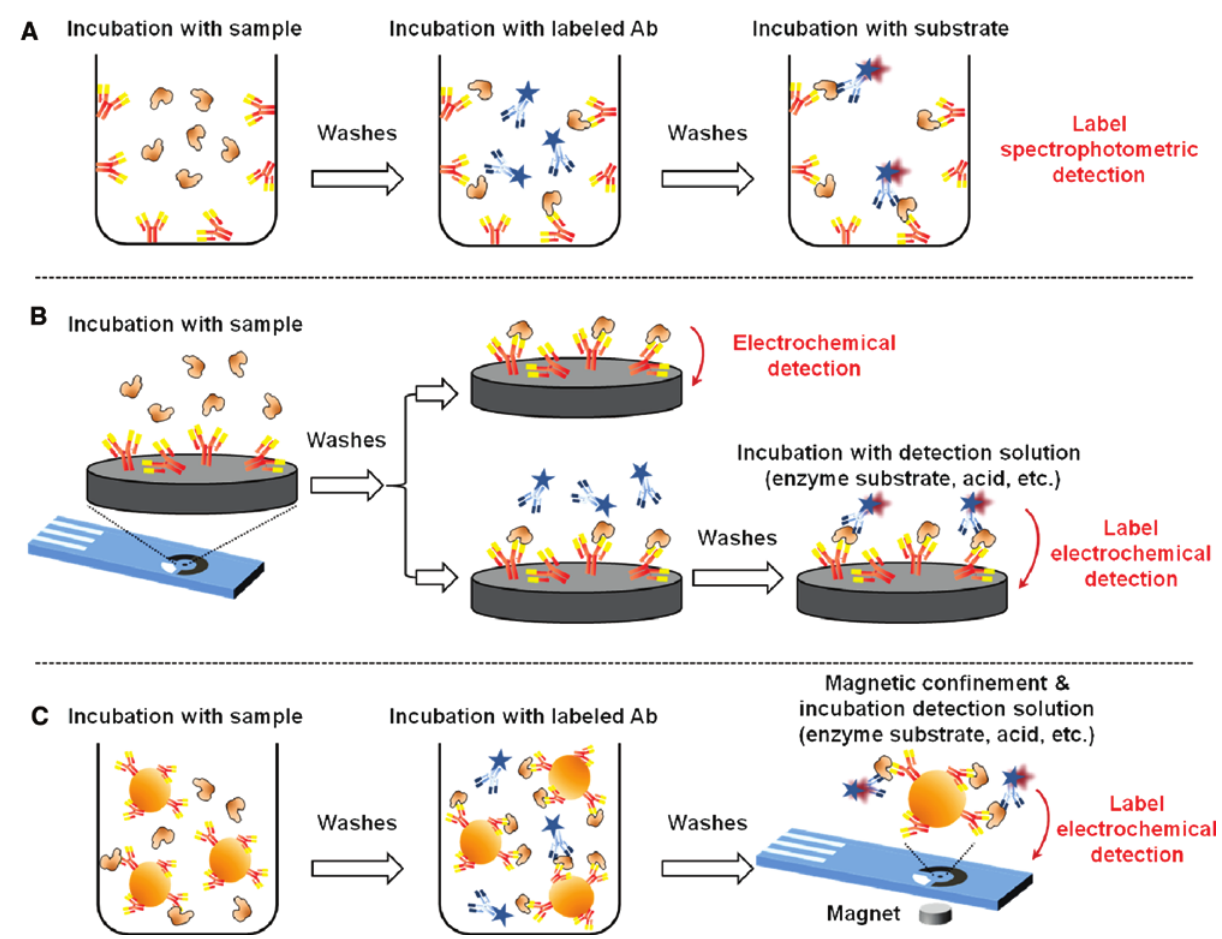
Figure 1: Scheme of different immunoassay and immunosensor formats. (A) Classical multistep ELISA performed at microtitter plate wells. Detection is carried out by incubating with an enzyme-labeled Ab and detecting spectrophotometrically the enzyme activity by adding the appropriate chromophore enzyme substrate. (B) Electrochemical immu- nosensor developed by immunoengineering of the electrode surface coupled to either straightforward detection of the immuno-binding event (top) or incubation of a labeled Ab and detection of the label. (C) Electrochemical magnetoimmunoassay performed at the surface of immunomodified MP. Immediately before electrochemical detection, MP have to be confined onto the surface of an electrode using a